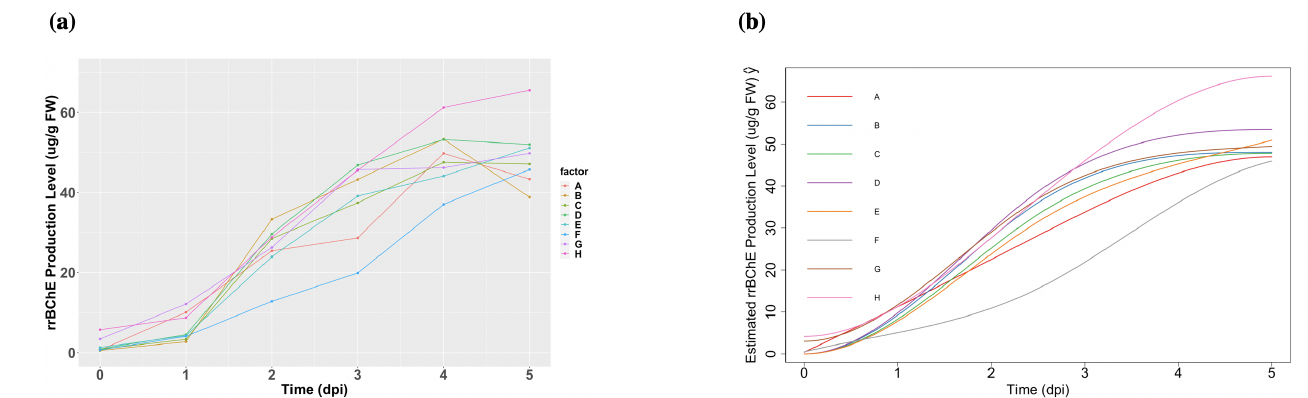
Figure 3. ( a ): The observed cell-associated rrBChE production levels in factors A to H. ( b ): Fitted curves with monotonicity in factors A to H